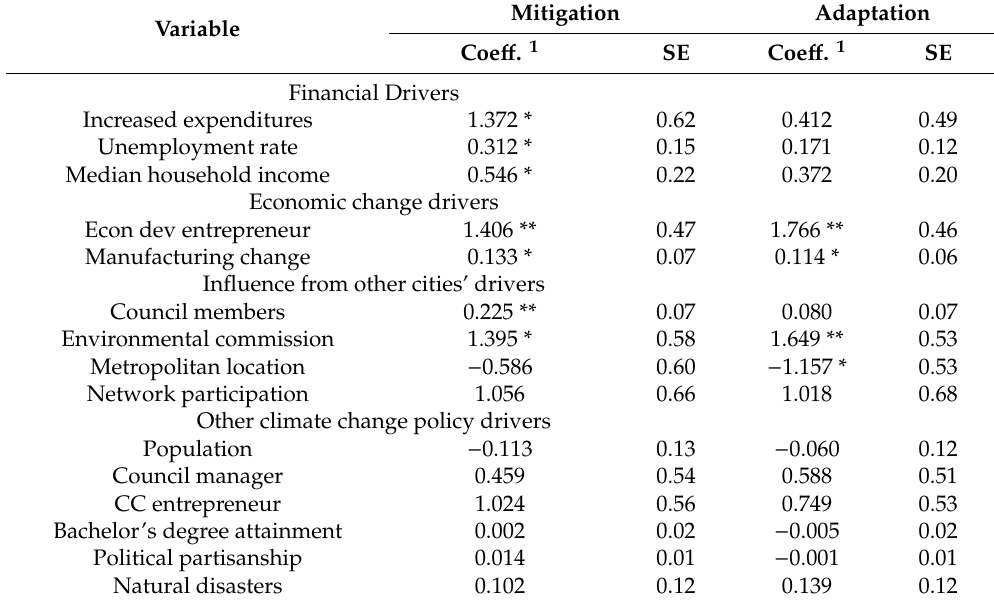
Table 3. Logistic regression results: City high engagement with climate